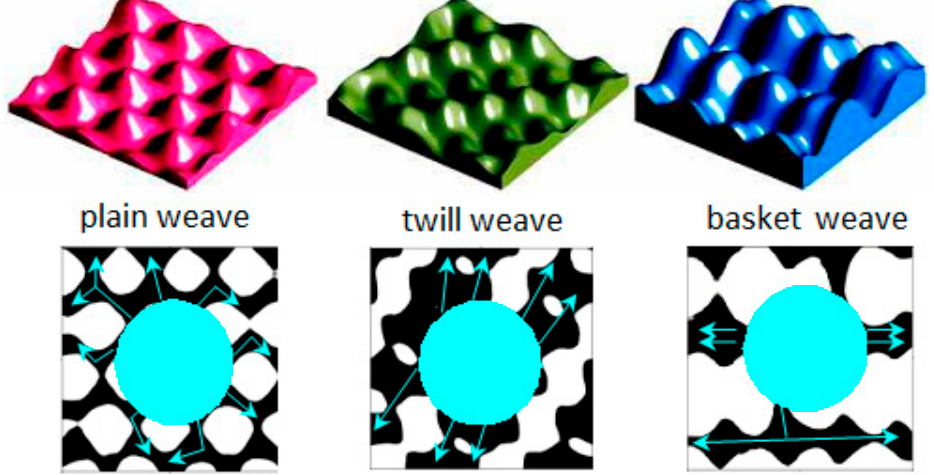
Figure 3. Topographic structure of fabrics in plain, twill and basket weave and the direction of movement of liquid droplets on the fabric surface [17].